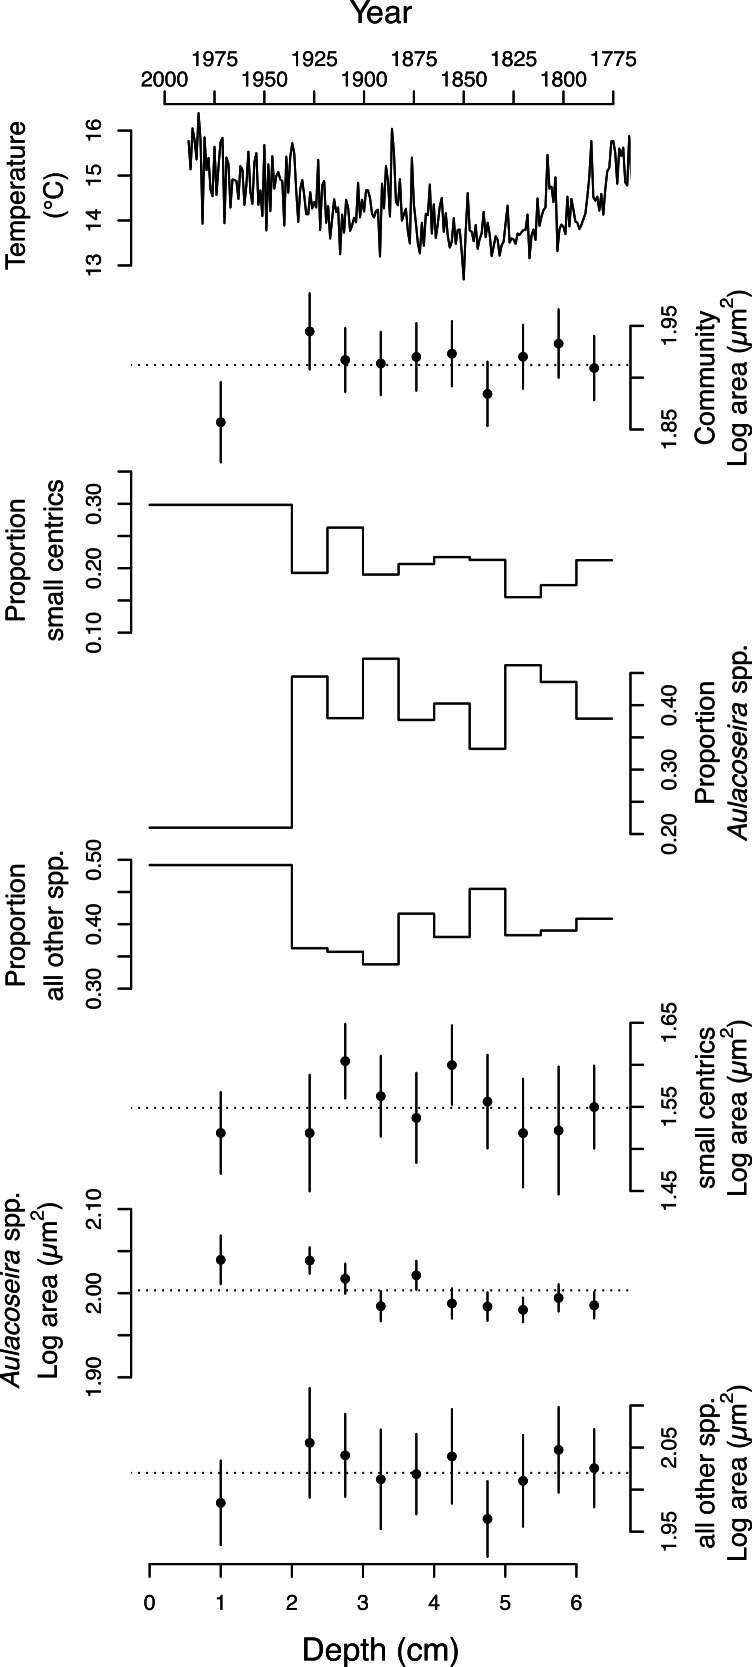
Change in the size and taxonomic structure of the diatom community and selected sub-populations over the last ∼200 years.From top to bottom: regional spring-summer temperature reconstruction (Szeicz & MacDonald, 1995), the average log10 area (µm2) of valves from the diatom community, the proportion of small centric diatoms with diameters <10 µm in the community; the proportion of Aulacoseira spp. in the community, the proportion of all other species in the community, the average log area (µm2) of the small centric diatoms with diameters <10 µm, the average log area (µm2) of dominant Aulacoseira species, the average log area (µm2) of all the other species in the community. Errors bars represent 95% confidence intervals.